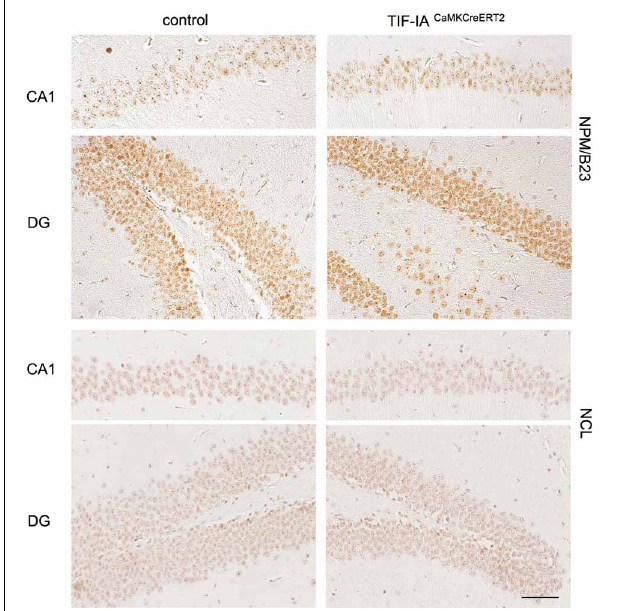
FIGURE 3 | Nucleolar integrity is altered in CA1 and DG of TIF-IA CaMKCreERT2 mutants. Representative images of IHC with the nucleolar markers nuclephosmin (NPM/B23) and nucleolin (NCL) in control and TIF-IA CaMKCreERT2 mutant mice 1 month after tamoxifen showing reduced intensity of nucleolar staining of both proteins in the mutants. Scale bar: 60 μ